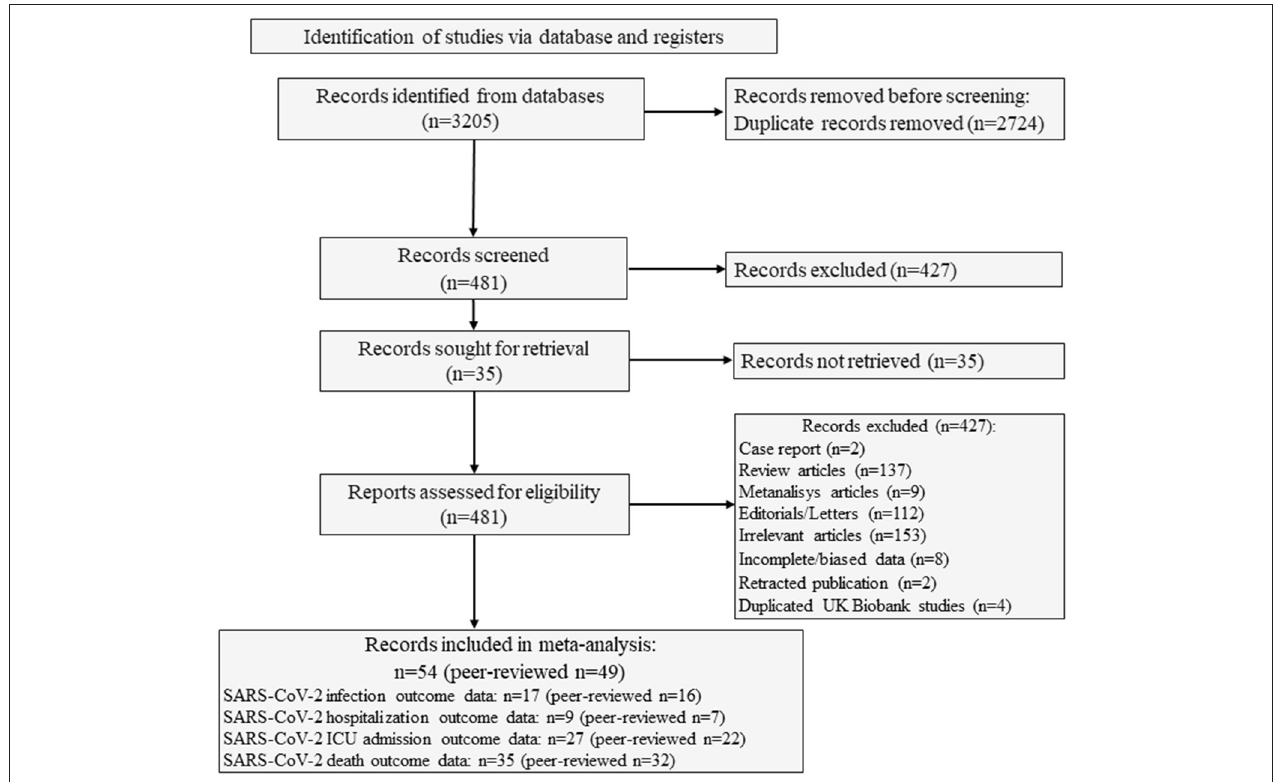
FIGURE 1 | Flow of study selection process. SARS-CoV-2, Severe Acute Respiratory Syndrome